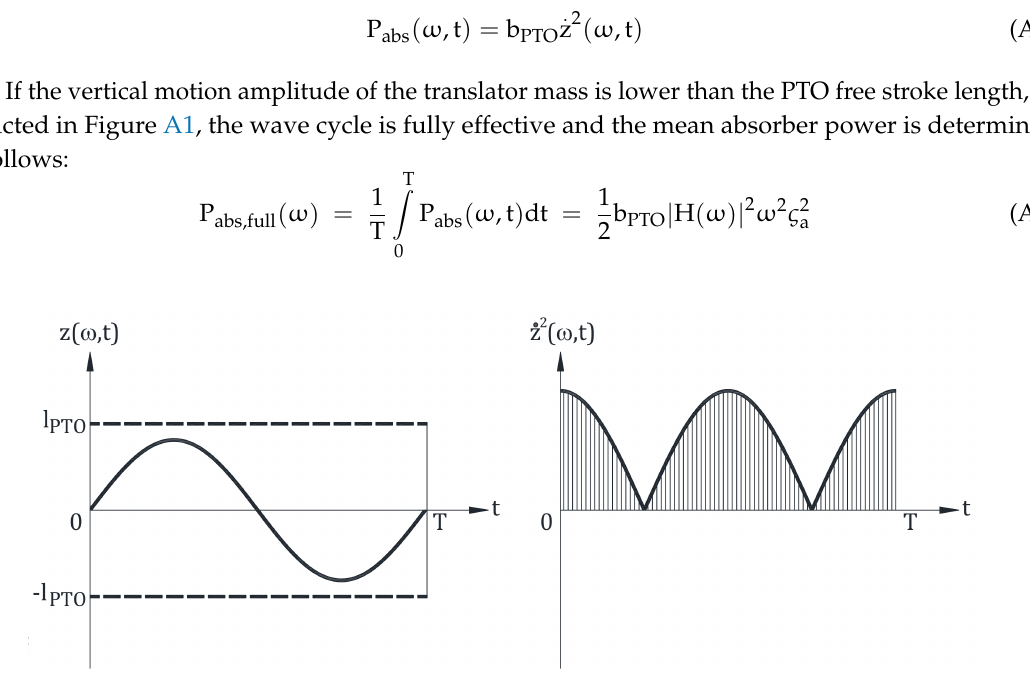
Figure A1. Power absorption without exceedance of PTO upper/lower stroke length (graphs are purely